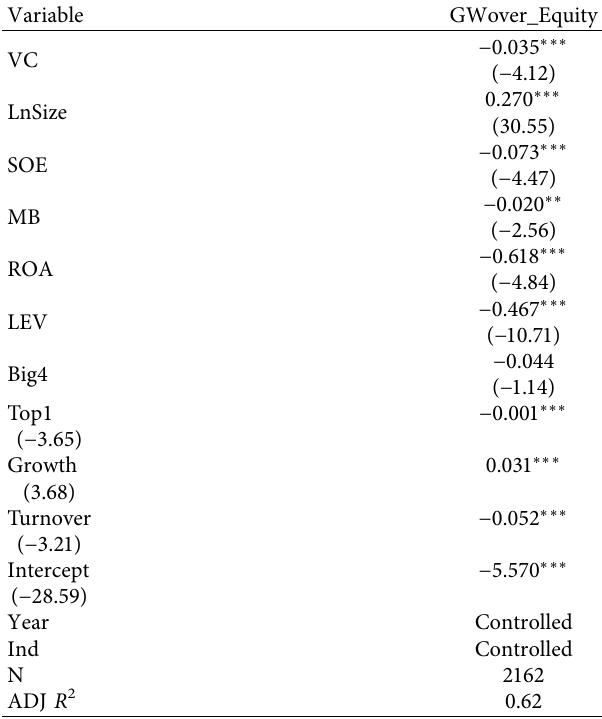
Table 10: Replacement of explained